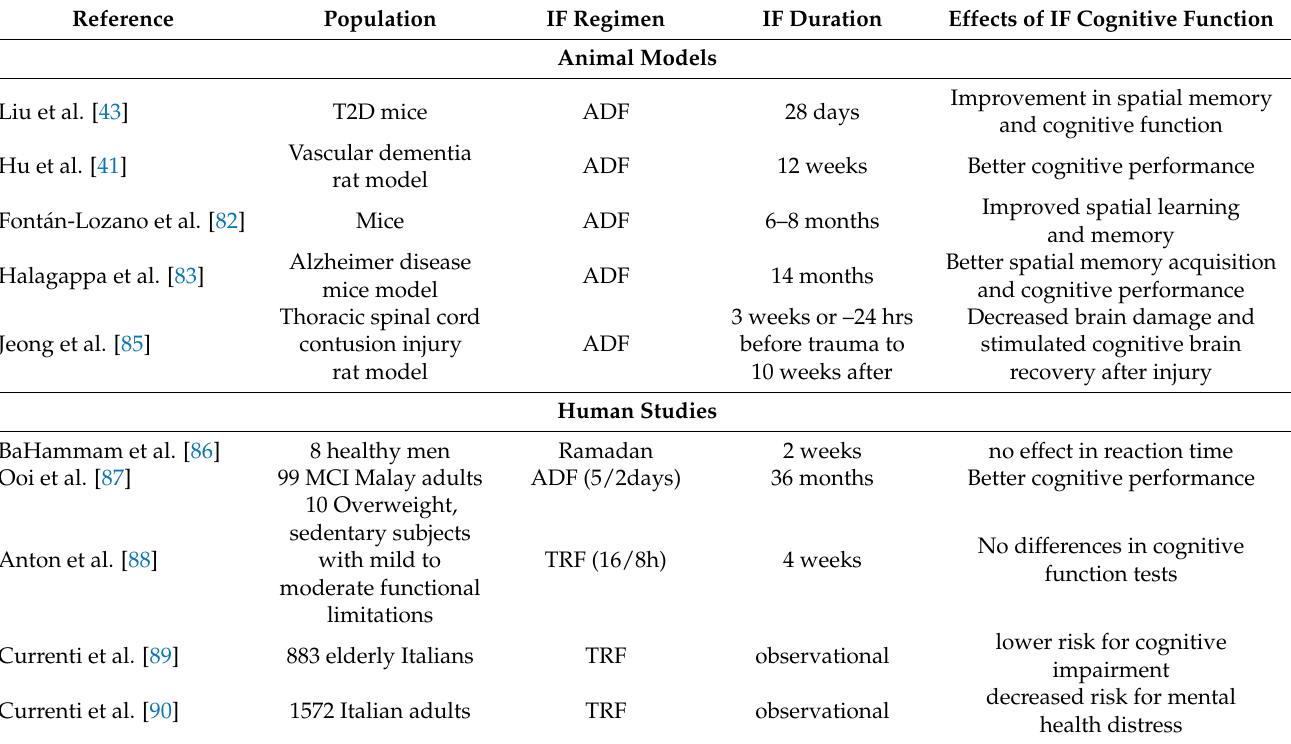
Table 1. Summary of the studies on animals and humans employing IF and its effects on cognitive function